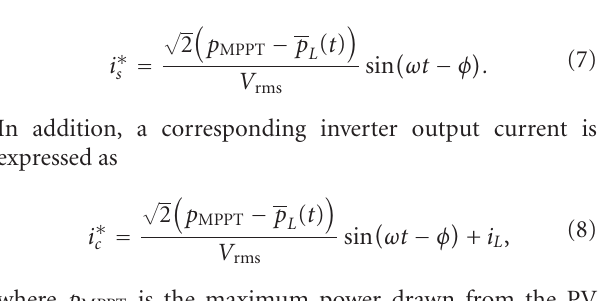
Figure 7: A trajectory to indicate operation points varying with insolation.